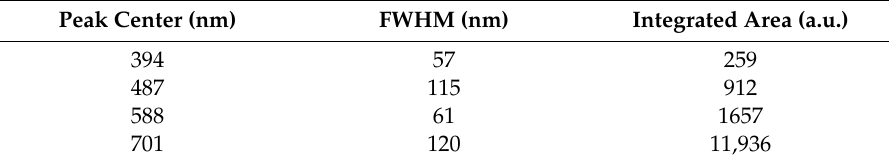
Figure 4. ( a ) Deconvoluted (black line) RT PL spectra (open dots) of γ –Bi 2 O 3 NPs. Inset in ( a ) shows a pie chart representing the integrated area of deconvoluted peaks; ( b ) a schematic energy level diagram for Bi 3+ valence state. Table 3. Summary of deconvoluted photoluminescence spectra of γ –Bi 2 O 3 NPs.